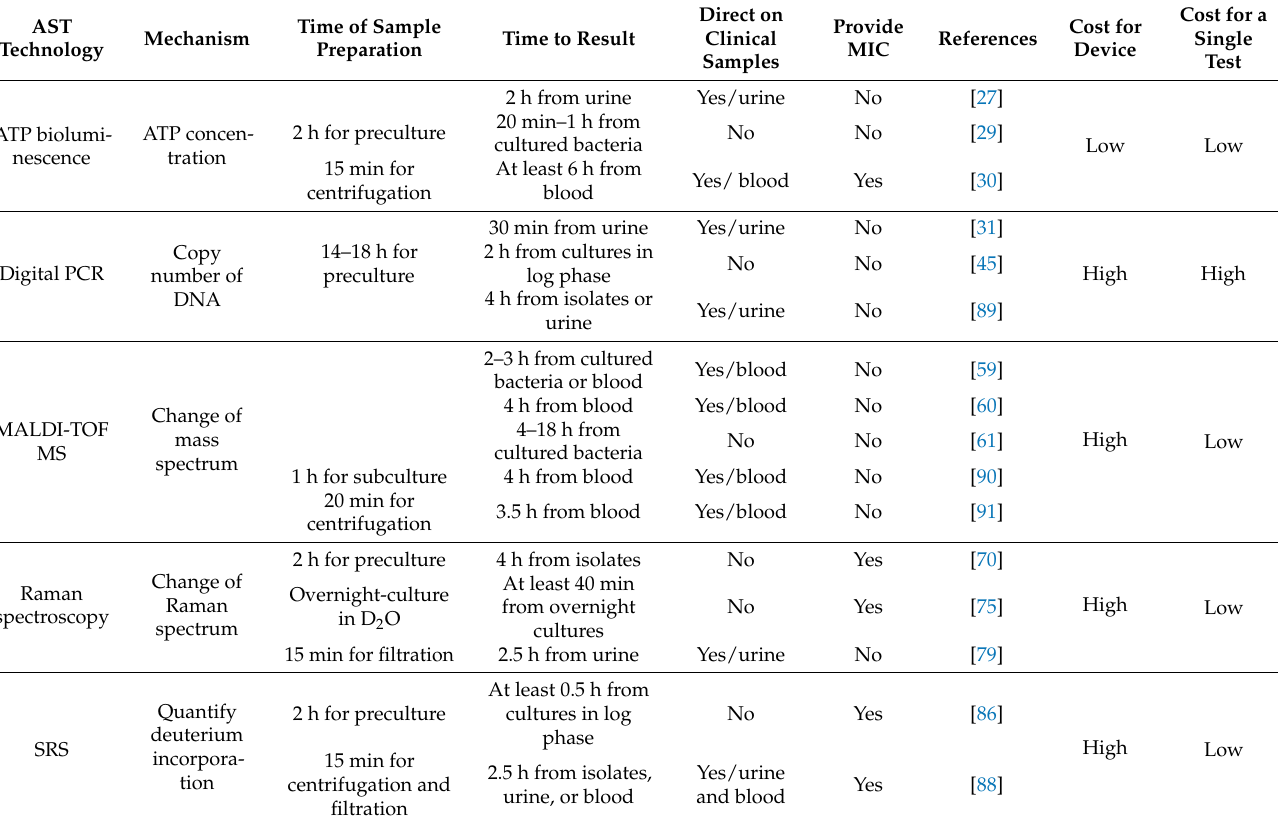
Table 1. Comparison of different existing rapid antimicrobial susceptibility testing (AST) methods based on metabolic profiling. Time of Sample AST Time to Result Mechanism Preparation Technology